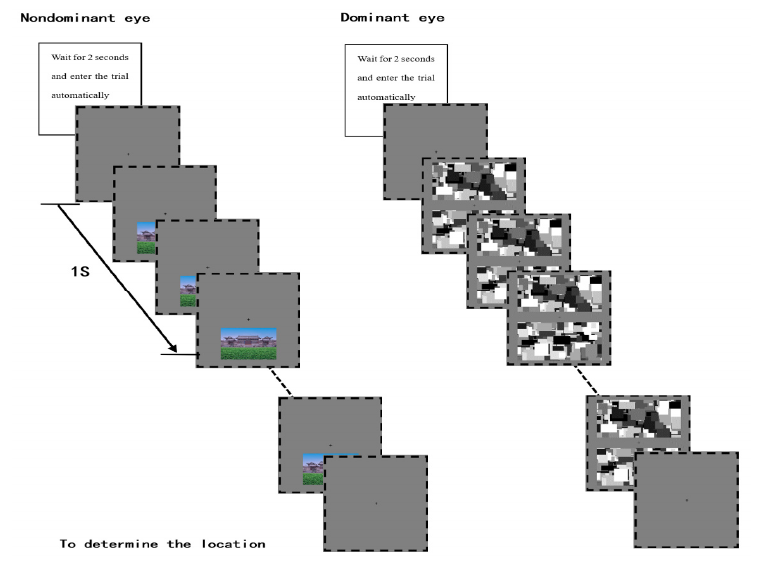
Figure 4. Schematic representation of the experiment.